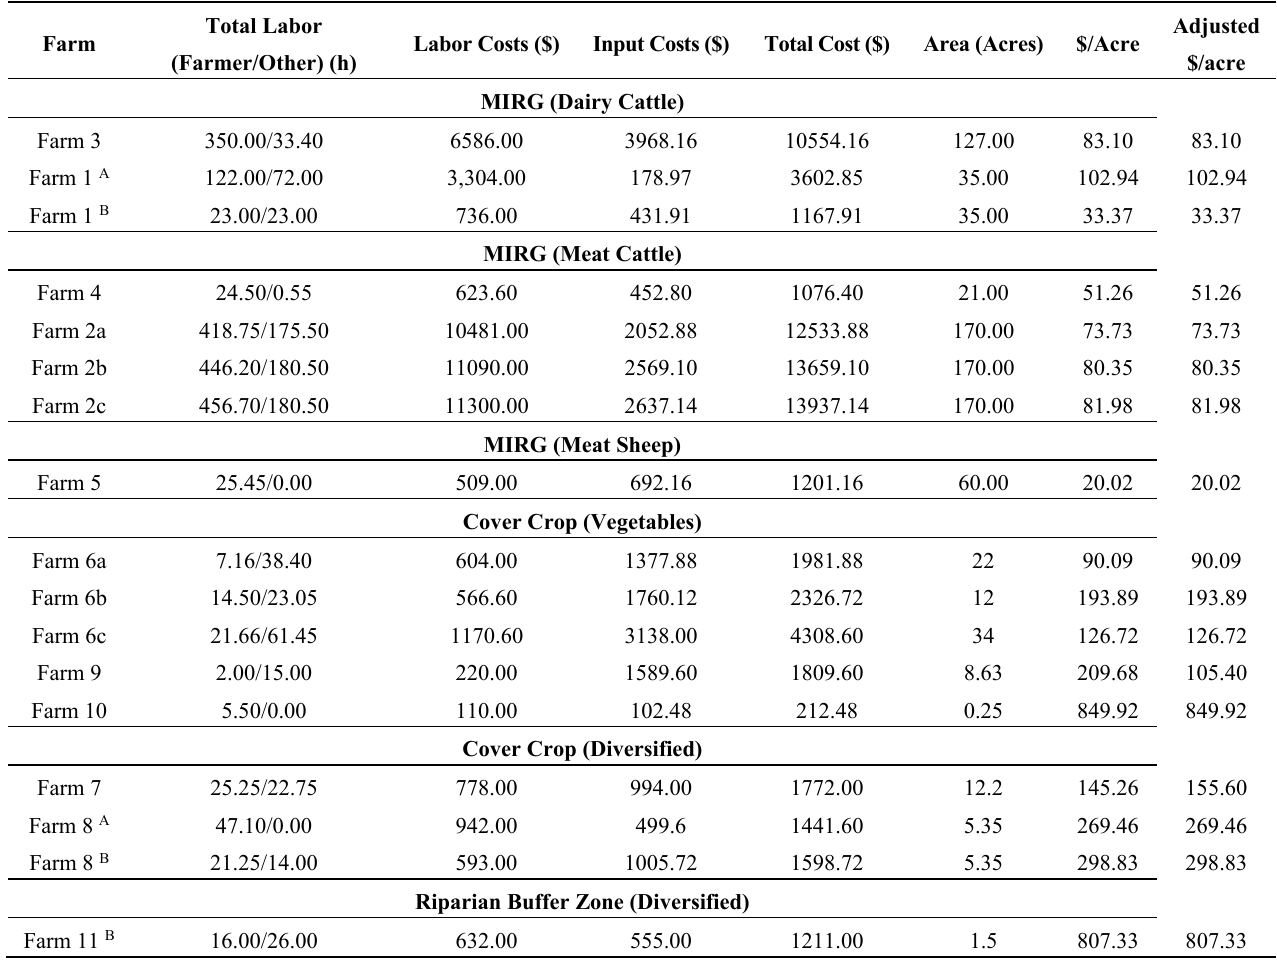
Table 1. Annual Climate Change Best Management Practice